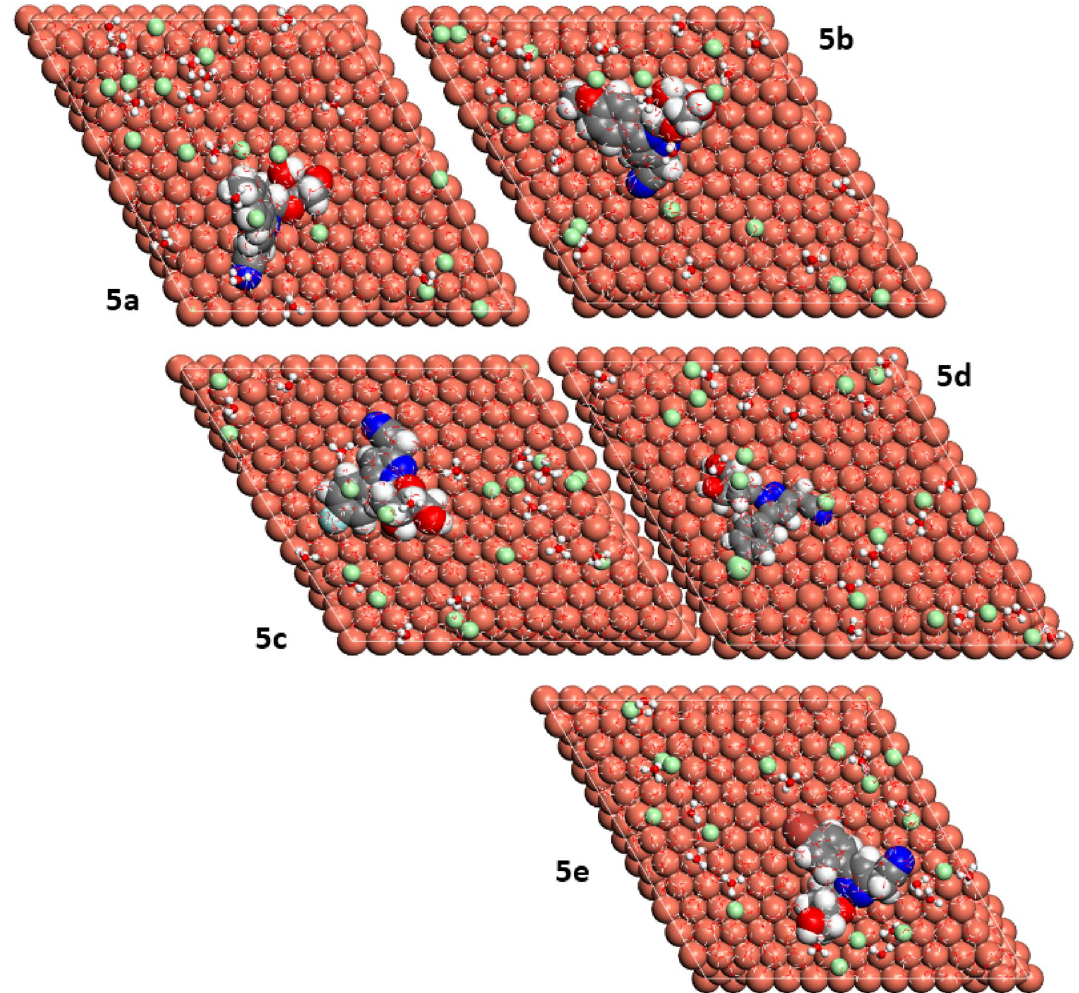
Figure 7. Top view of adsorption configurations of 5a – e on Cu(111) in aqueous